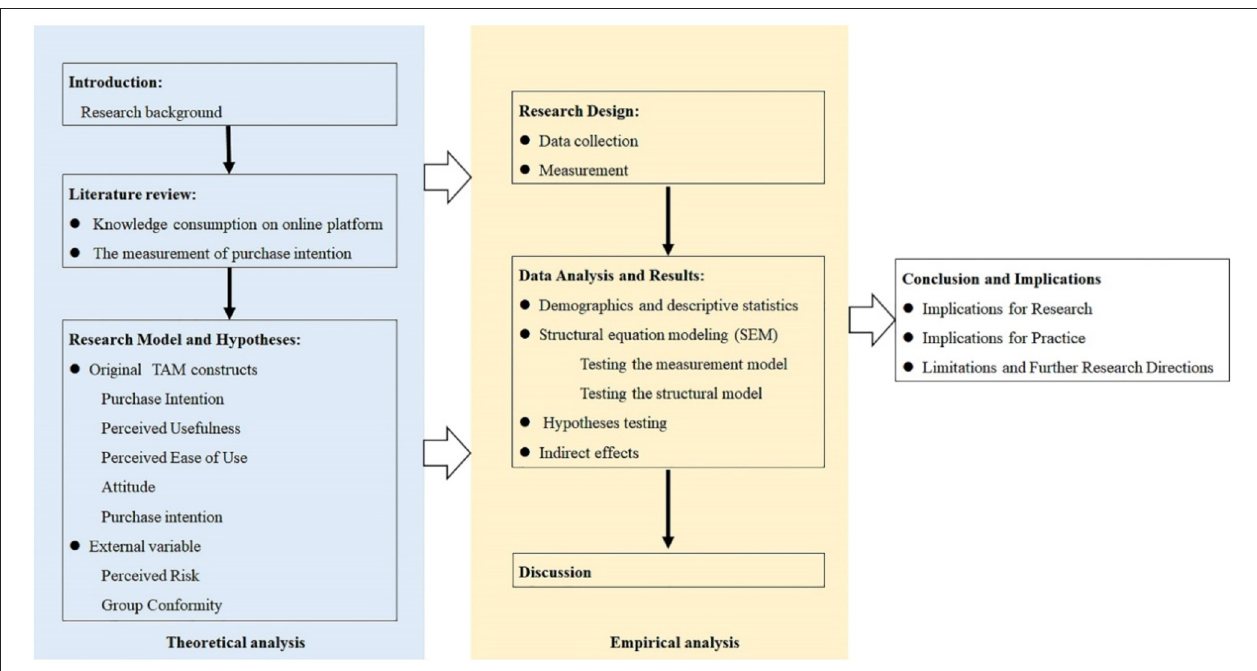
FIGURE 1 | The frame diagram of the research